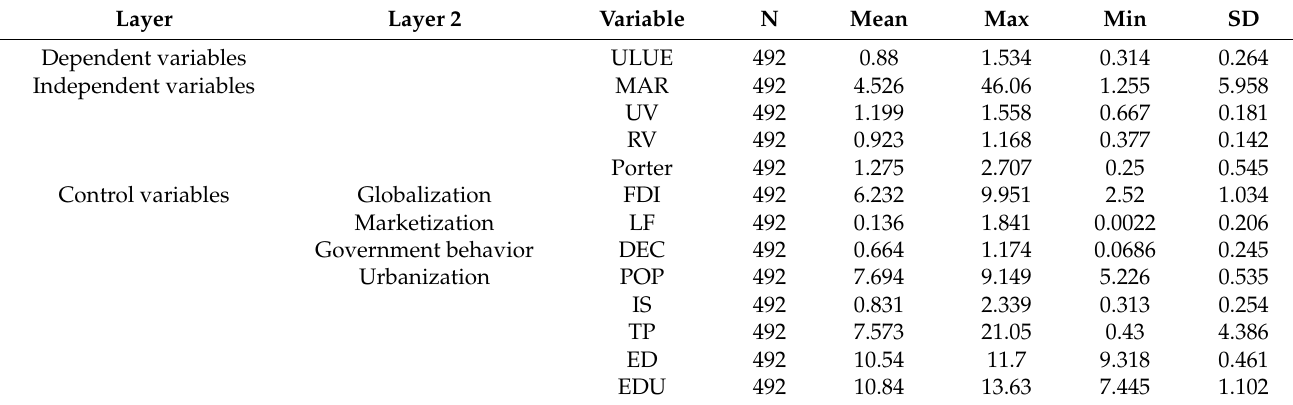
Table 3. Statistical description of the selected